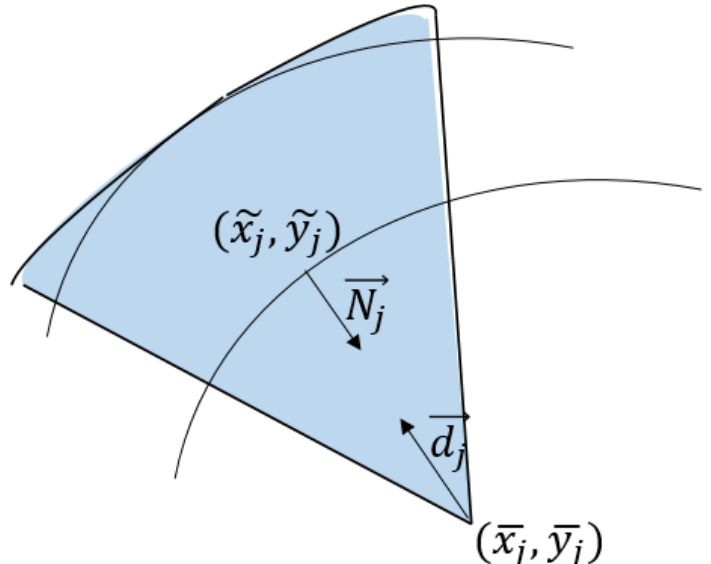
Figure 13. ( ¯ x j , ¯ y j ) is the position of s for outer curve of Boundary ( ˜ A ) and sensing area of s being tangent to each other.